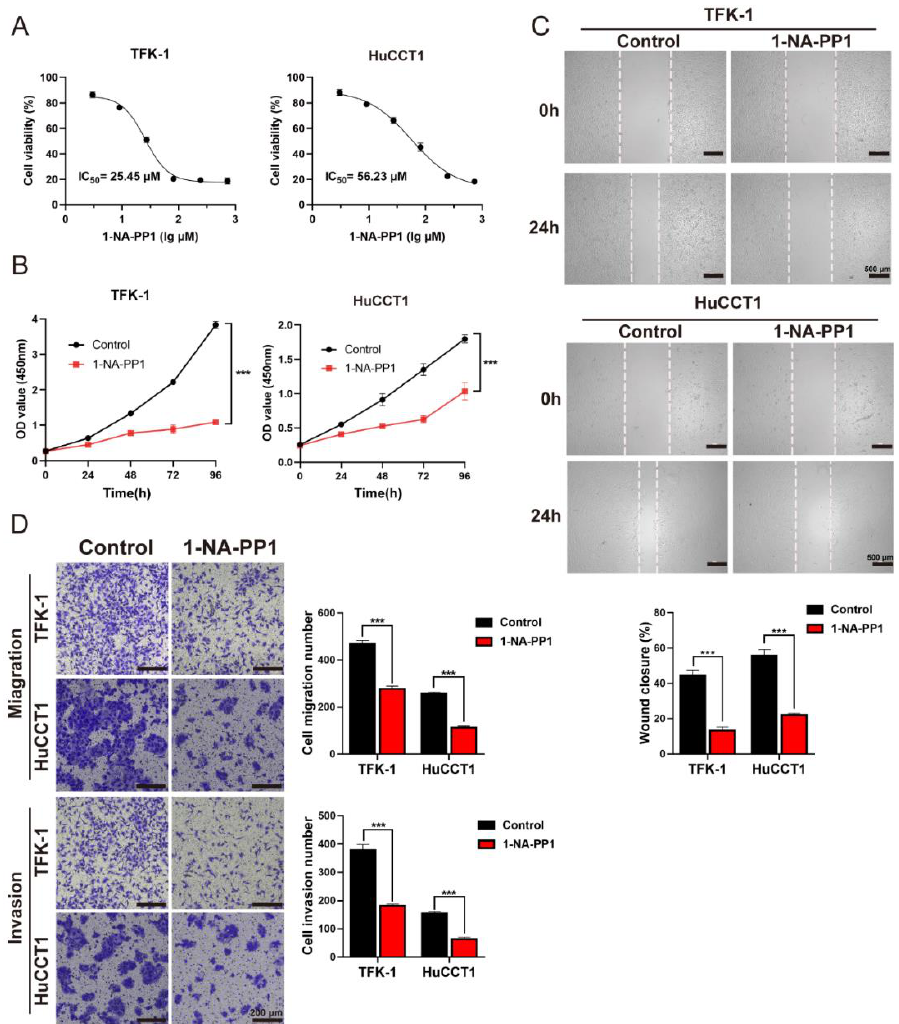
Figure 8. Experimental analysis of 1-NA-PP1 in CCA cells: ( A ) CCK8 assay was performed to measure the median inhibition concentration (IC 50 ) on TFK-1 and HuCCT1 cells; ( B ) proliferation of TFK-1 and HuCCT1 cells treated with 1-NA-PP1 was measured by CCK-8 assays; ( C ) representative phase-contrast images of TFK-1 (top) and HuCCT1 (bottom) cells at 0 and 24 h treatment with 1-NA-PP1. Scale bars = 500 μm. ( D ) The Transwell migration and invasion assays of TFK-1 and HuCCT1 cells were after the 24 h treatment with 1-NA-PP1; the concentration of 1-NA-PP1 in treating TFK-1 and HuCCT1 was 25.45 μm and 56.23 μm, respectively. Scale bars = 200 μm. *** p < 0.001, determined by two-way ANOVA. Data are presented with means ± SDs and from three independent experiments.